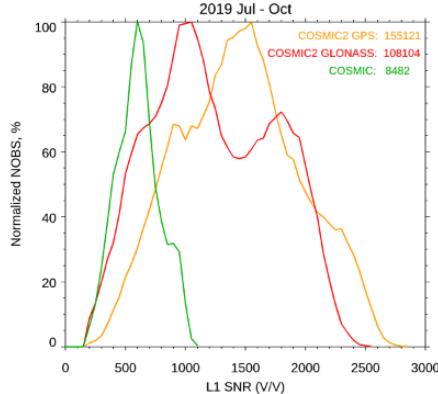
Figure 1. The histograms of the normalized accumulation (in %) L1 SNR for COSMIC (in green line), COSMIC-2 with GPS emitter (in orange line), and COSMIC-2 with GLONASS emitter (in red). The SNR is computed from the average SNR values from 60 km to 80 km geometric height range of the L1 signal. We normalized the lines to the maximum of the sample number of the SNR bin. The mean L1 SNR for COSMIC is equal to 700 v / v , where that for COSMIC-2 / GLONASS samples and COSMIC-2 / GPS samples are equal to 1100 v / v and 1250 v / v , respectively. All the data are collected from June to October